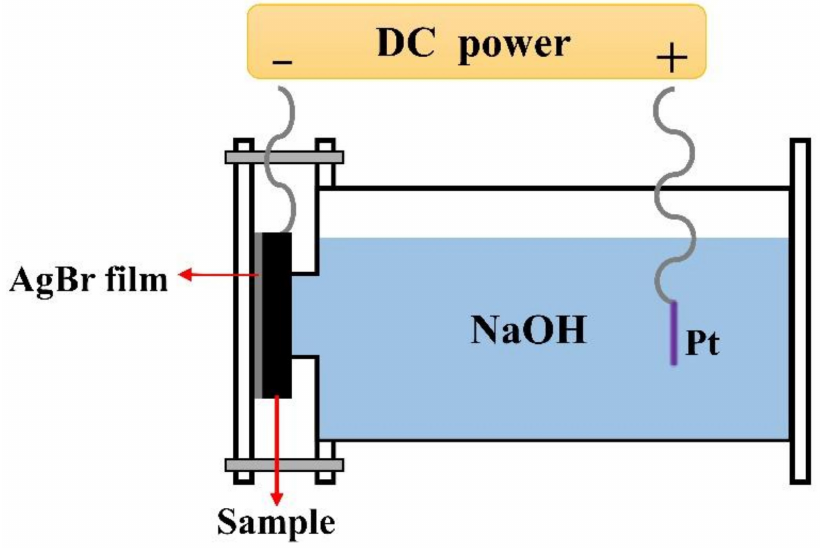
Figure 1. Schematic diagram of single-side hydrogen charging in the HMT process. The hydrogen charging parameters of HMT were the same as those in the tensile test process in Section 2.2, while hydrogen was charged for 6